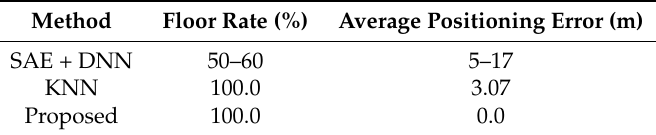
Table 3. Experimentation results for option 1.